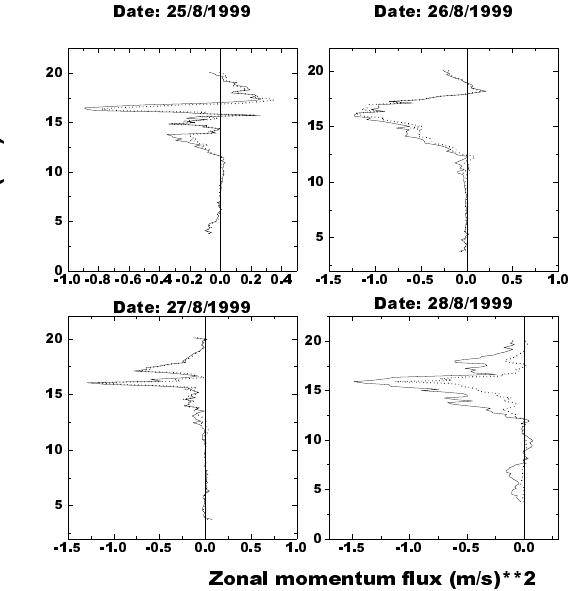
Fig. 8. The spectrum of radial velocities observed using east, west, north and south beams at 14.1km altitude on 25 August 1999.